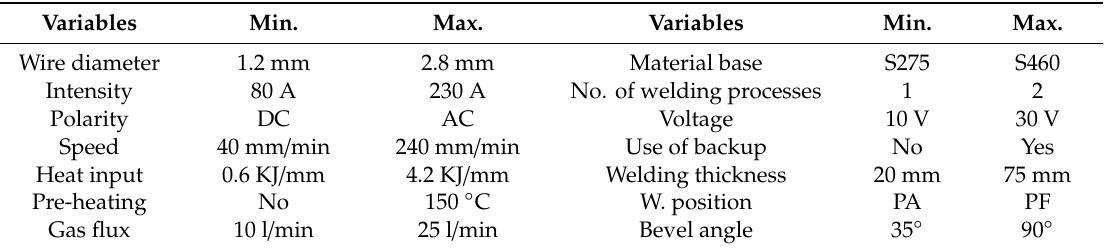
Table 2. The range for di ff erent variables of the test